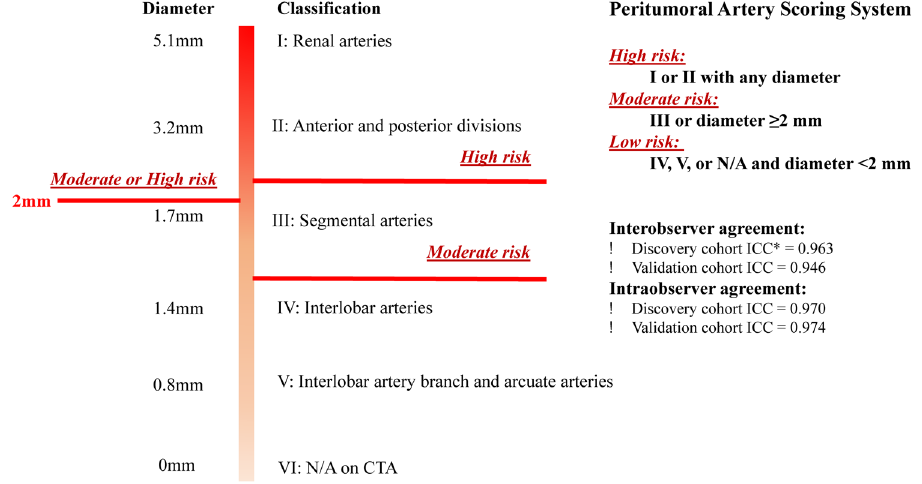
Figure 1. Spectrum of peritumoral arteries and definition of Peritumoral Artery Scoring System. The range of diameter was evaluated by 3D Volume Rendering (VR). * Interobserver agreements were assessed by using Intraclass Correlation Coefficients